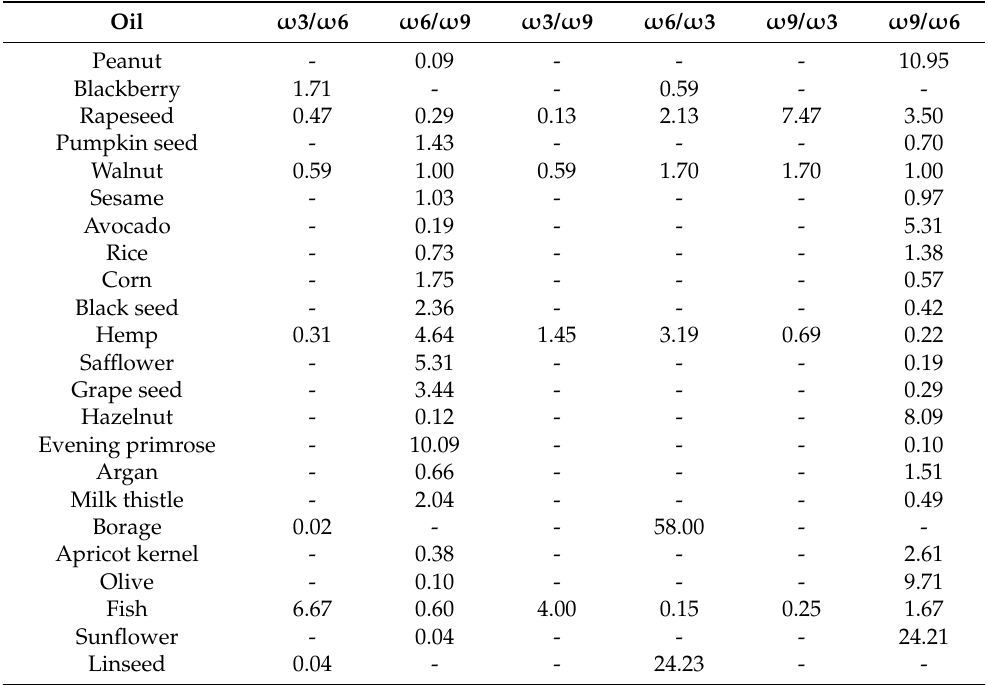
Table 1. The quantitative ratios of ω -PUFA and ω -MUFA acids in fish and vegetable oils. The data were established based on information provided by Oleofarm (Poland) and Sigma-Aldrich (Steinheim,